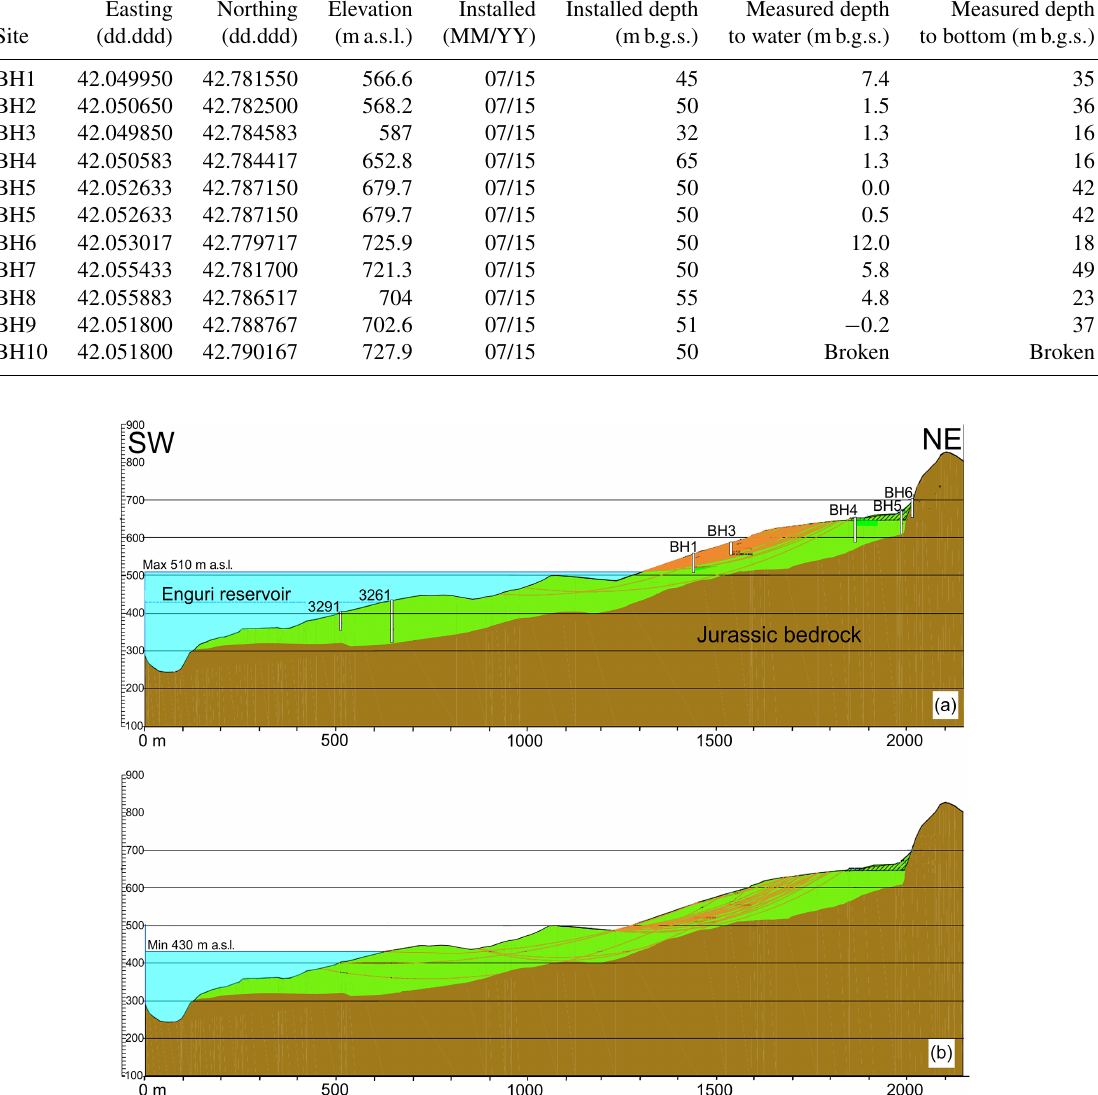
Figure 11. Sections of the static analysis developed to assess the effect of variation of the water level in the main landslide body. (a) Instability developed with a maximum level of the reservoir water (orange lines show the slip surfaces with FS < 1). (b) Analysis of the effect of variation of the reservoir water level down to the minimum level; note new slip surface (with FS < 1) formation at lower elevations.